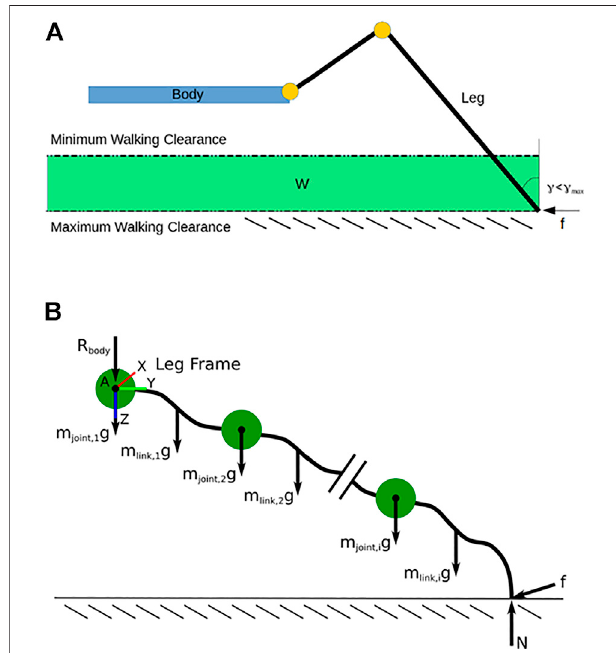
FIGURE1|(A) Avisualizationofthewalkingregion W . (B) Thefreebody diagram of a single leg cut away from the body and making contact with the ground. The green circles represent joints as lumped particles, the black lines represent rigid links whose actual geometry is being optimized, and the dotted line represents the ground